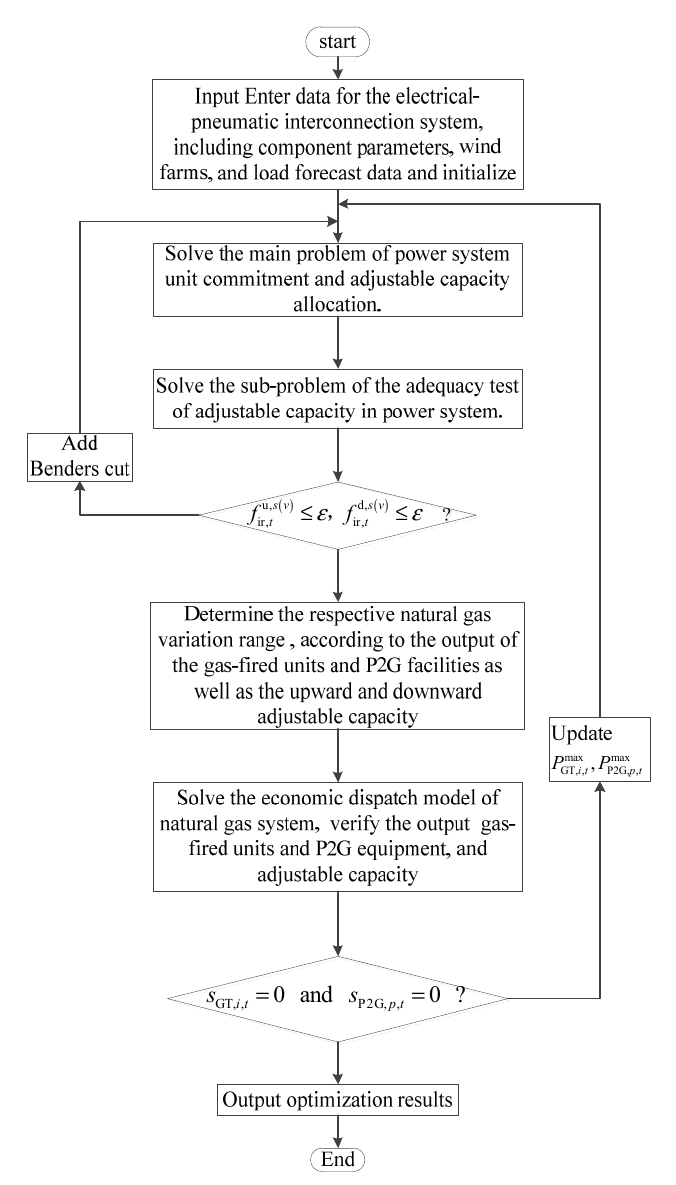
Figure 1. Flowchart of the model solution.